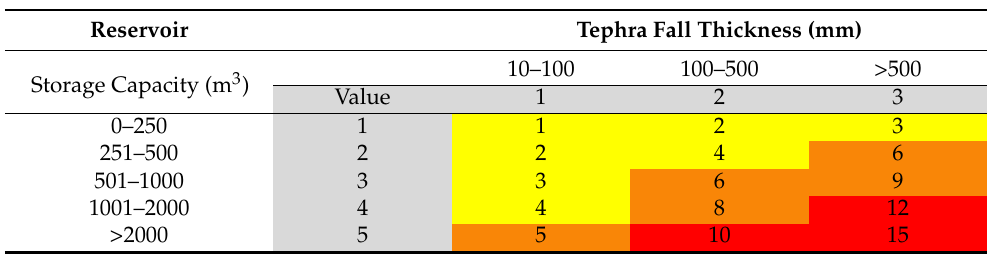
Table 3. Vulnerability matrix for the storage capacity of the water reservoirs (threshold values for tephra fall thickness adapted from [3]. Tolerance status (1–4) in yellow, disturbance in orange (5–9) and damage in red